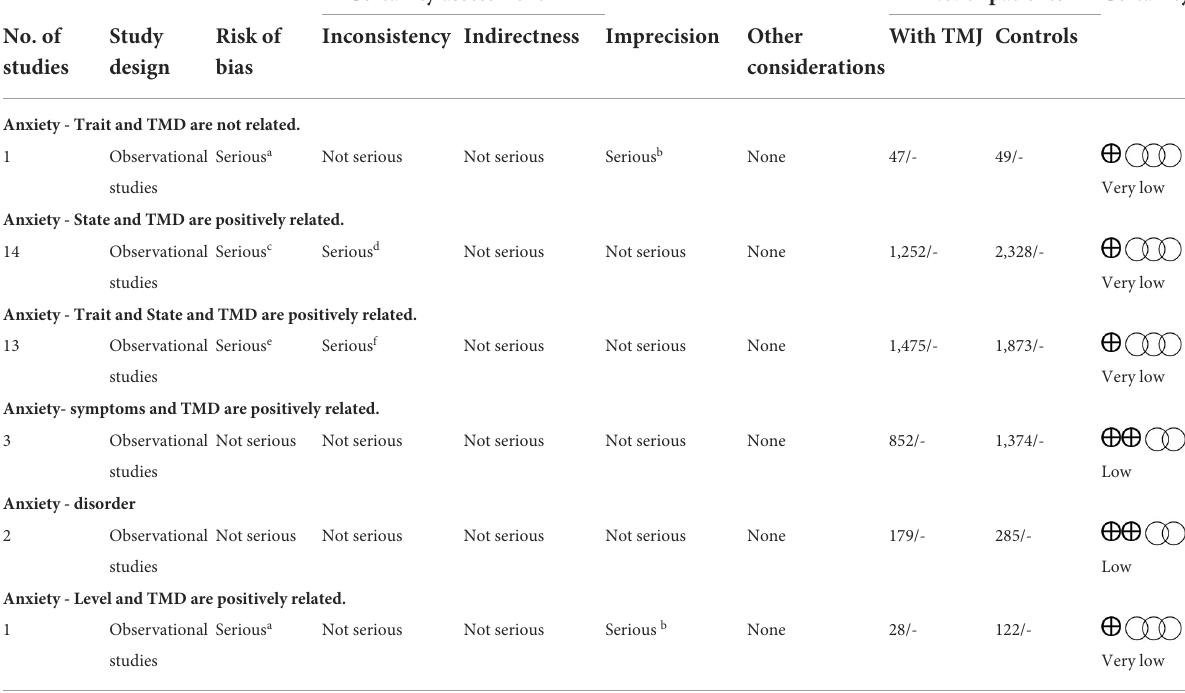
TABLE 4 Certainty of evidence. Certainty assessment No. of